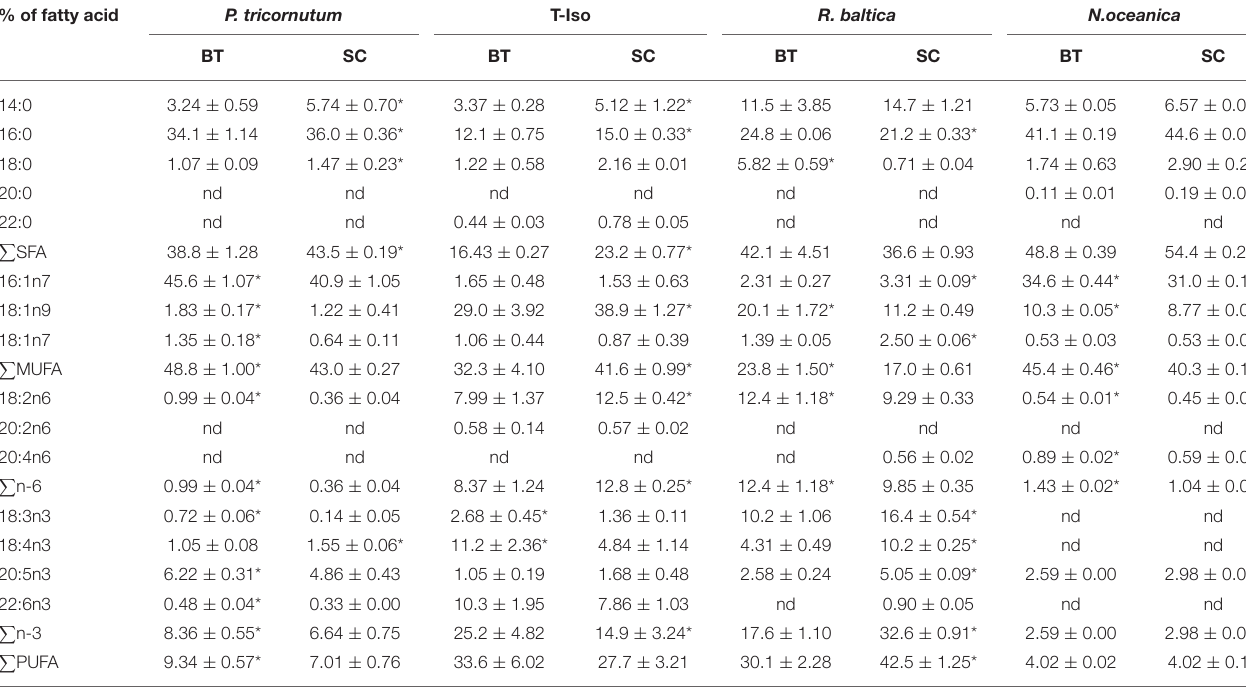
TABLE 3 | Fatty acid profiles in triacylglycerol (TAG) of four microalgae species cultured under nitrogen limitation, by batch (BT), and semi-continuous culture (SC). % of fatty